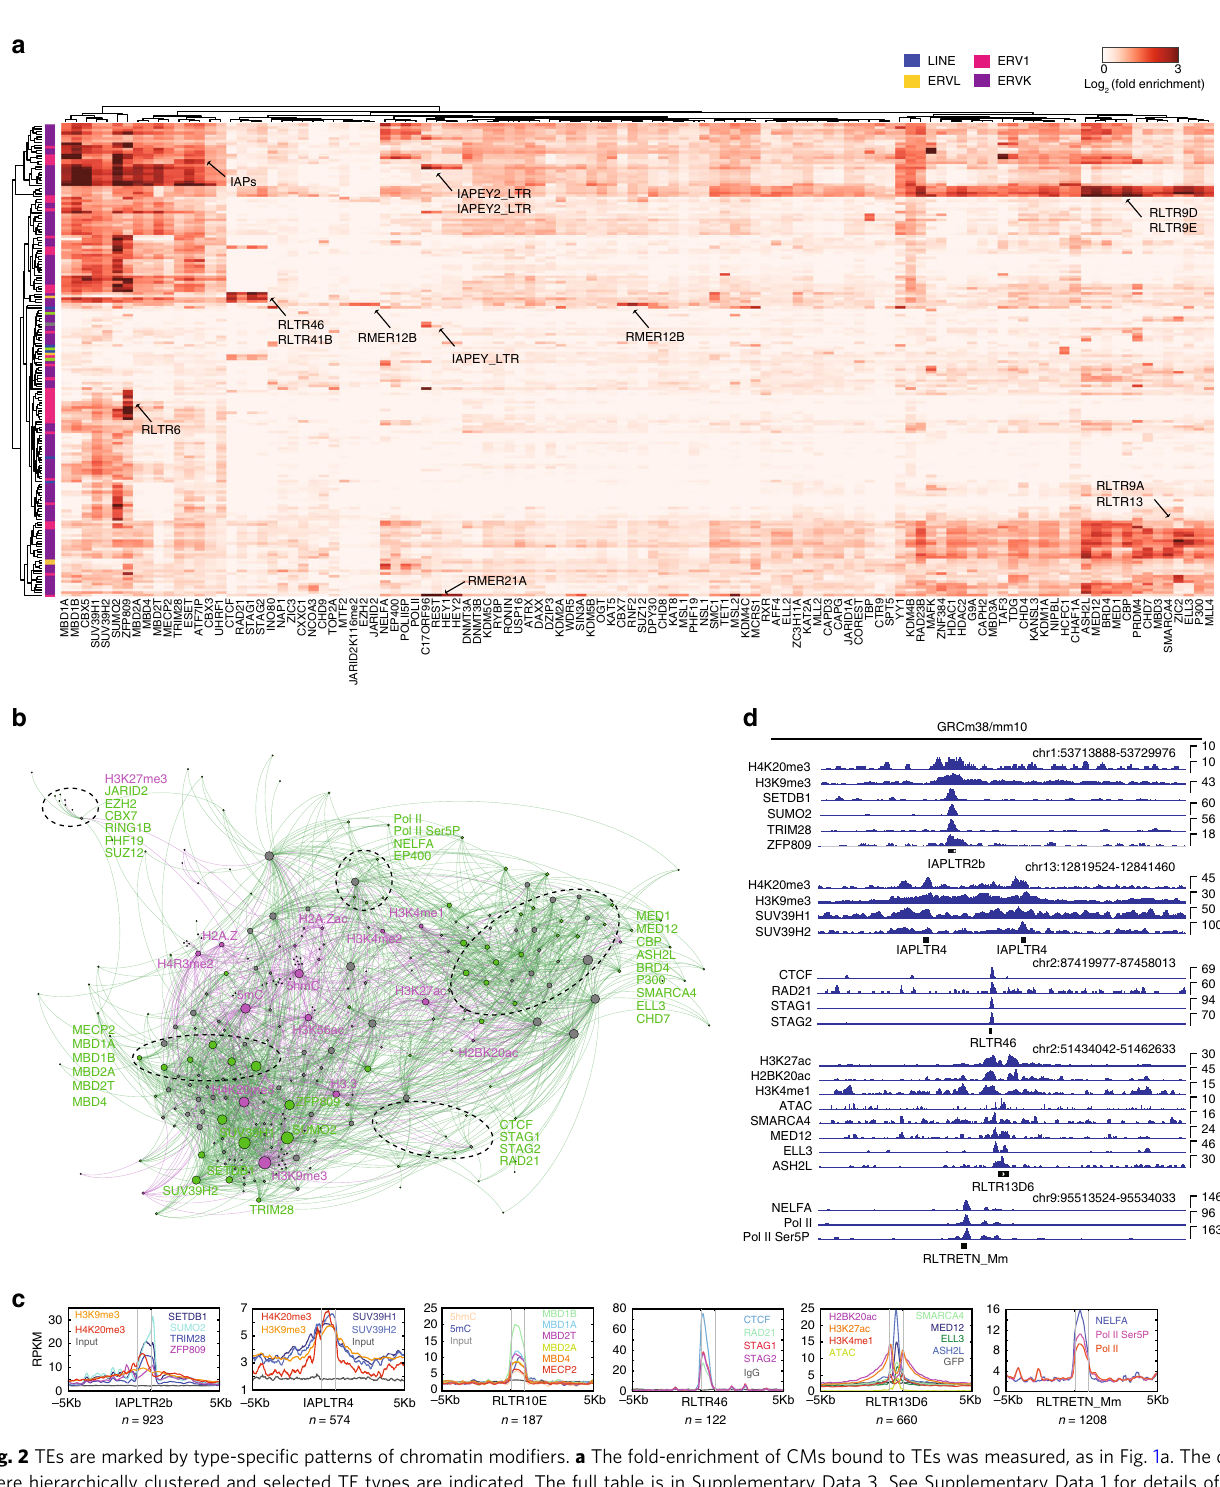
Fig. 2 TEs are marked by type-speci fi c patterns of chromatin modi fi ers. a The fold-enrichment of CMs bound to TEs was measured, as in Fig. 1a. The data were hierarchically clustered and selected TE types are indicated. The full table is in Supplementary Data 3. See Supplementary Data 1 for details of the samples used in this study. b Relational network for the chromatin marks (purple), the selected CMs (green), and TEs (gray). Edges were drawn between a chromatin mark and a TE, or a CM and a TE, if the chromatin mark or CM was enriched at least 2-fold. Node sizes are proportional to the network degree. Selected subgroups are indicated on the network. c Read count tag density pileups (In RPKM) of the indicated chromatin marks and CMs for the selected TEs. The TEs were scaled to the same size, and the fl anking 5 kb regions are shown. The gray line indicates the input/IgG control. d Example genomic views for the indicated TEs, chromatin marks and CMs are indicated. Care should be taken in interpreting genomic views due to uncertainty in mapping reads to speci fi c TE copies, this applies to all genome views in the